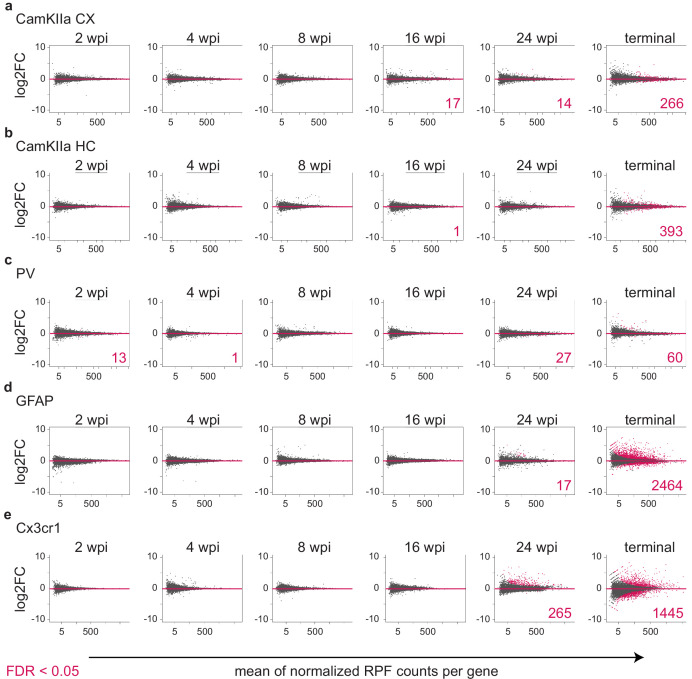
Identification of differentially translated transcripts in different cell types.MA plots showing the log2FC in translation between prion disease (PrD) vs control (ctrl) samples over the mean of normalized RPFs per gene. Genes that are differentially translated (FDR < 0.05) are colored in pink and the corresponding numbers are indicated.